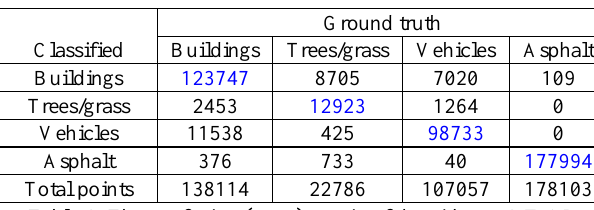
Table 1. The confusion (error) matrix of the airborne LIDAR